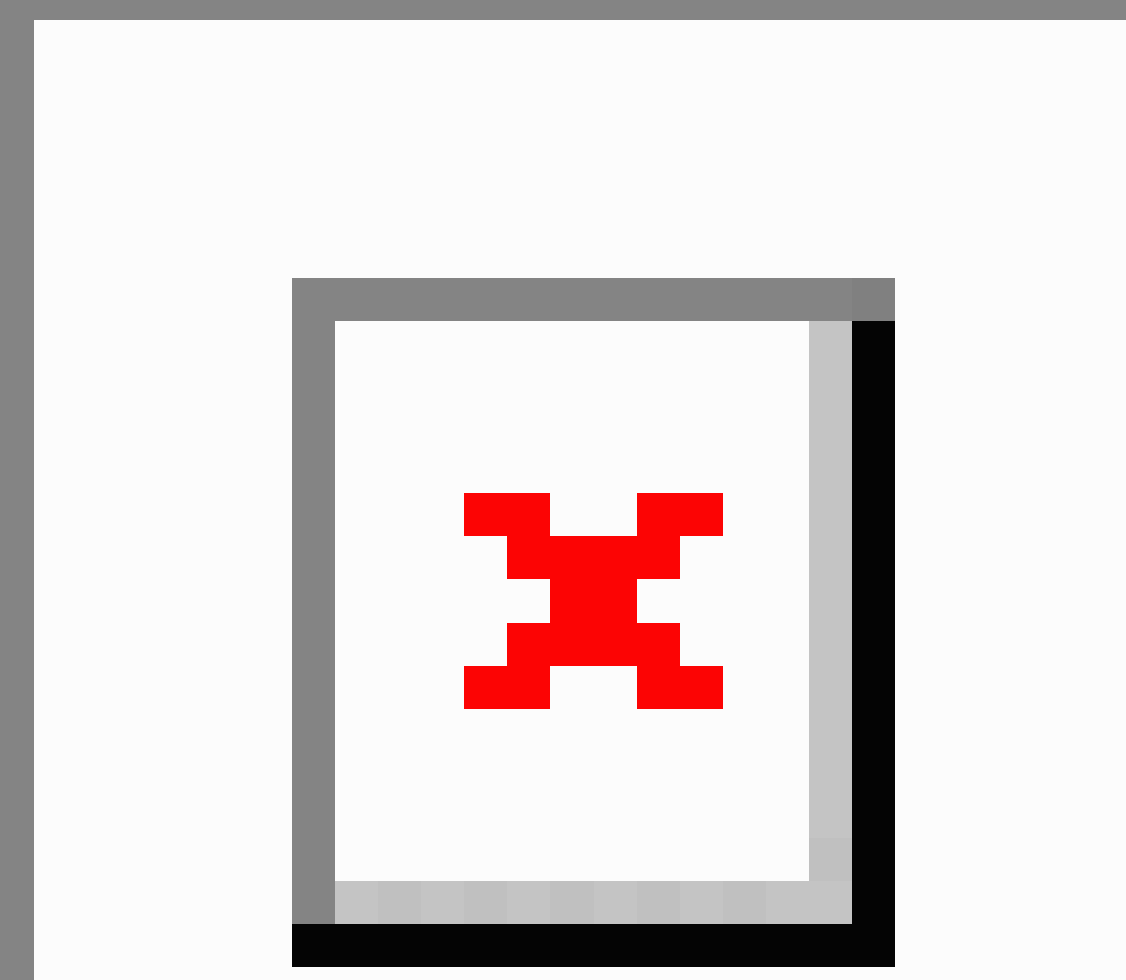
Figure 2. Neonatal requests at 6-month interval by cluster, health facility type and location, phone type, and time of day requests were made. P values are chi-square tests or Fisher exact test comparing requests within each subcategory of each explanatory variable at 6-month intervals. Clusters have been labeled A-H for anonymity; CHPS: Community-based Health Planning and